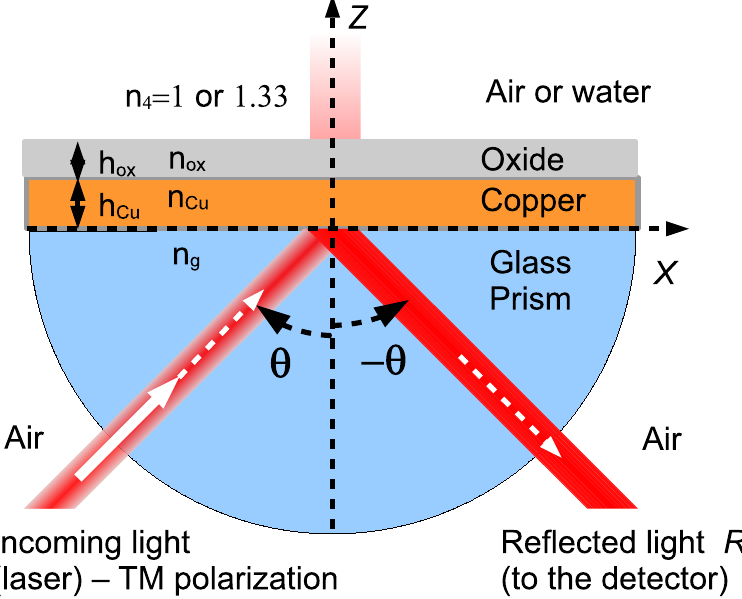
Figure 1. Schematic of the prism-based SPR sensor with the Kretschmann configuration. The plane material layers are deposited on the hemispherical